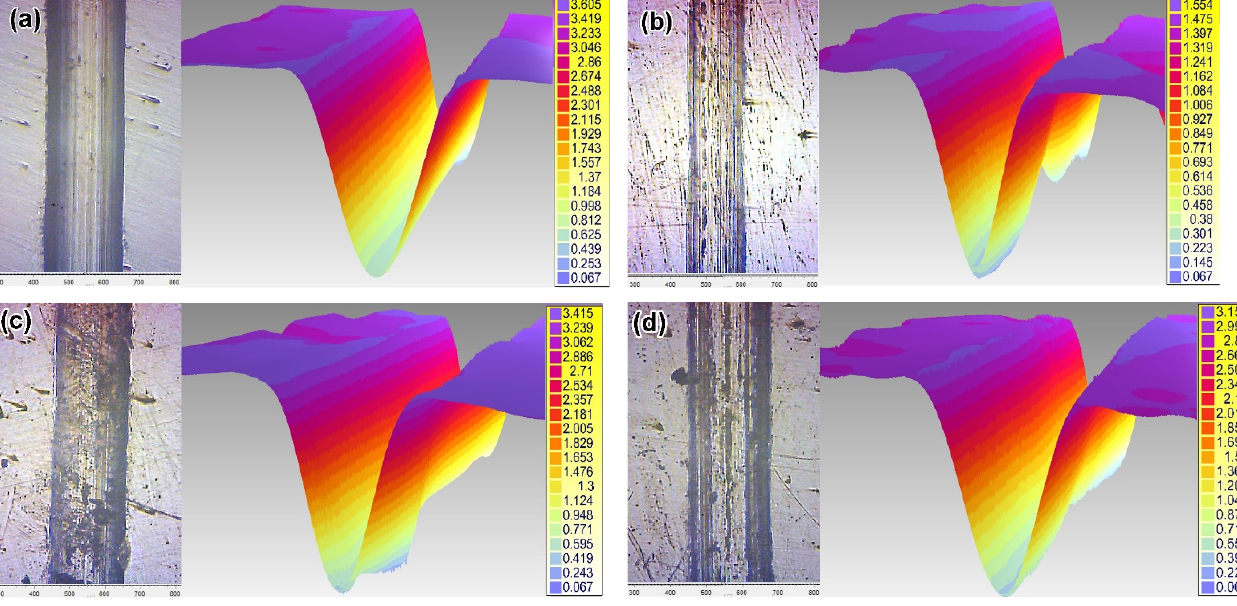
Figure 14. Wear tracks in plane and their 3D images after SBF sliding: ( a , b ) as-received specimens, ( c , d ) plasma-treated specimens, (( a , c ): plate 316T; ( b , d ): LPBF 316L) (the bar values are given in μ m).